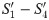
Nested 5-fold-CV performance of the MT method on the S1′-S4′ datasets.Numerical values can be found in Supporting Information S2 Table.